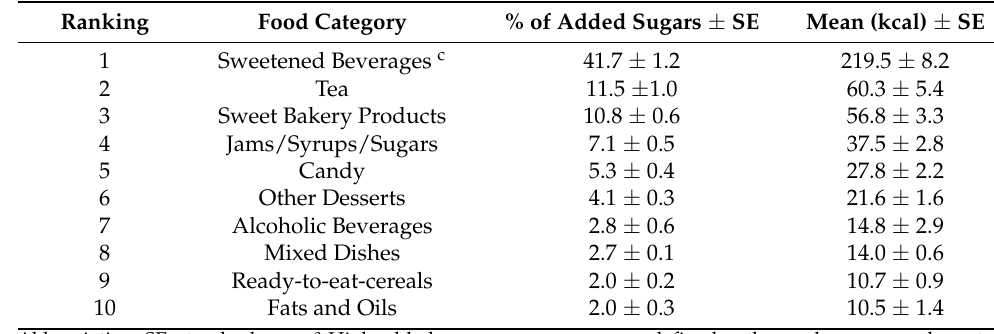
Table 4. Top 10 sources of added sugars and mean calorie intake from top sources among high consumers of added sugars a among US adults, overall and by race/ethnicity, NHANES 2015–2018, Day 1 dietary recall ( n = 3236) b